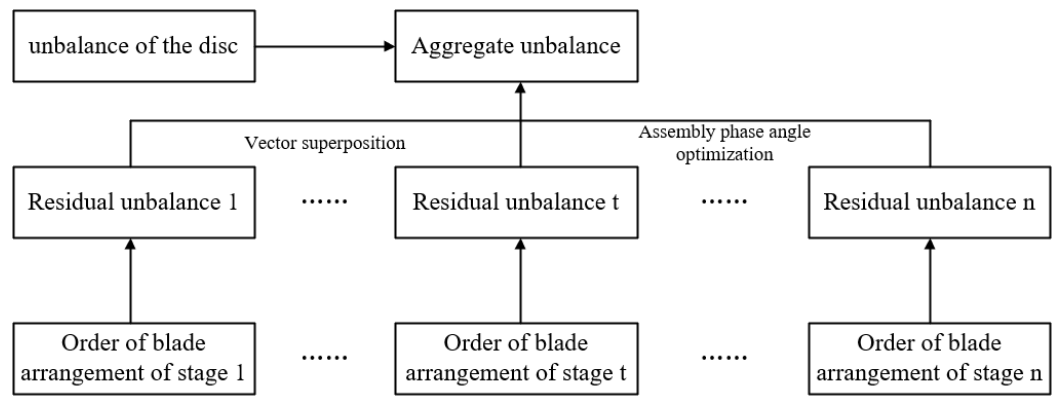
Figure 3. Fan rotor multi-stage blade assembly.